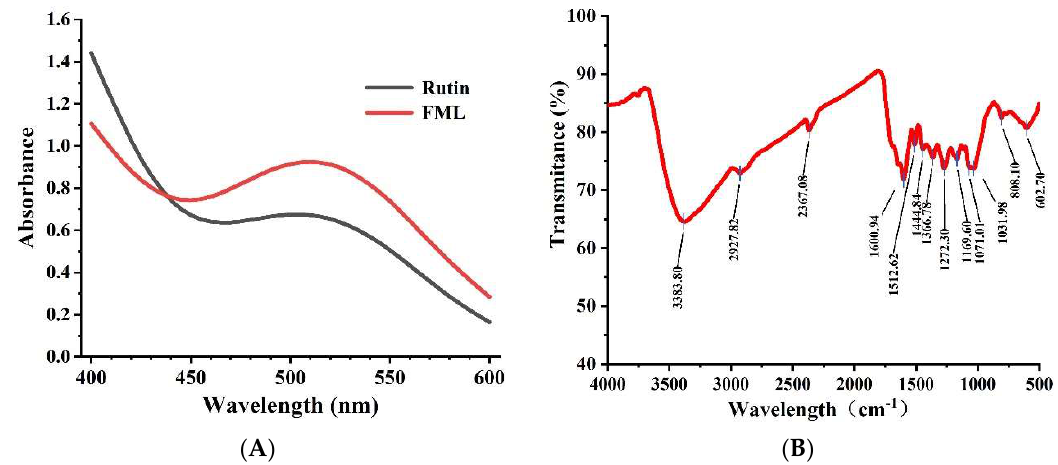
Figure 3. ( A ) UV scan spectrum of FML and rutin; ( B ) FT-IR spectrum of